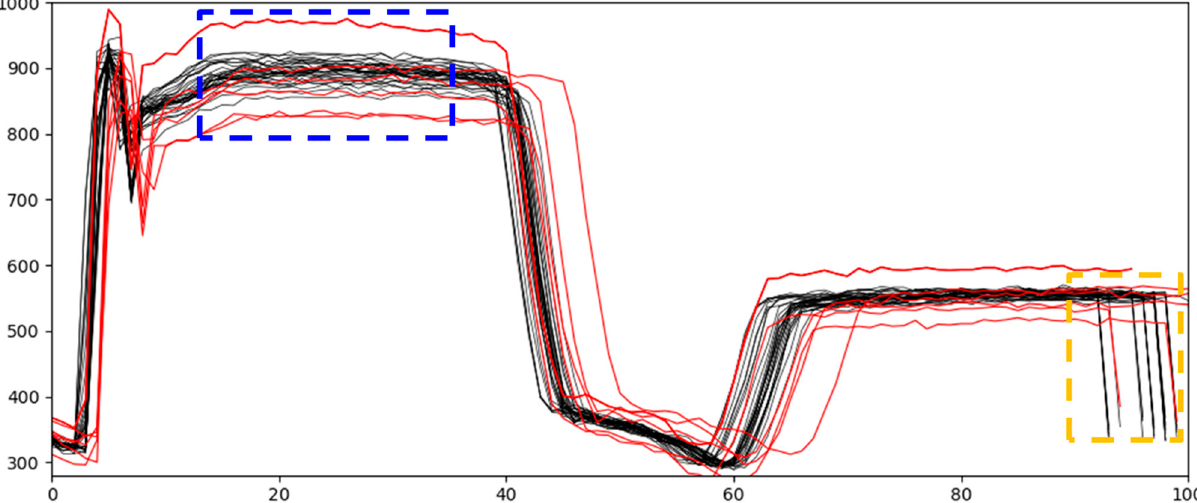
Figure 2. Example of normal (black) and abnormal (red) signals.